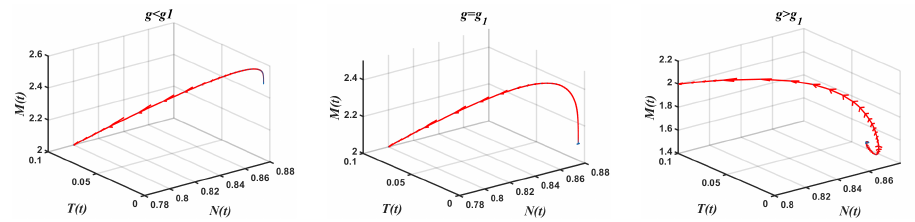
Figure 8. Phase portraits of model (1) for various g values corresponding to Figure